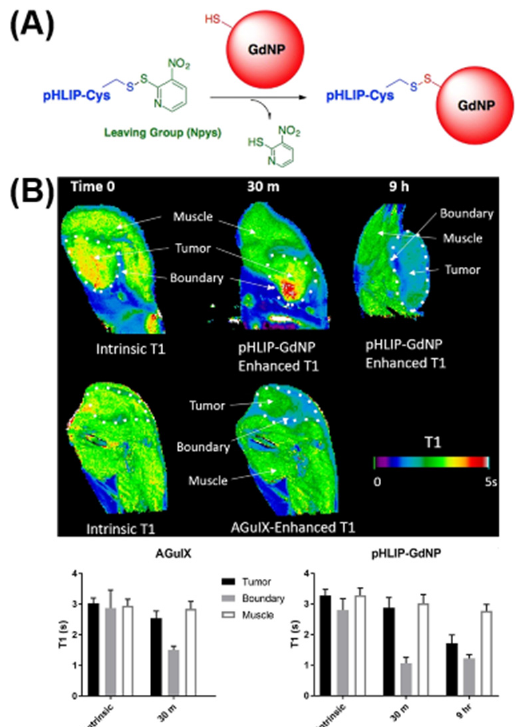
Figure 2. Preparation ( A ) and in vivo imaging ( B ) of pH-anchor gadolinium-based nanoparticles. Reprinted from [41] under the CC BY-NC-ND license.